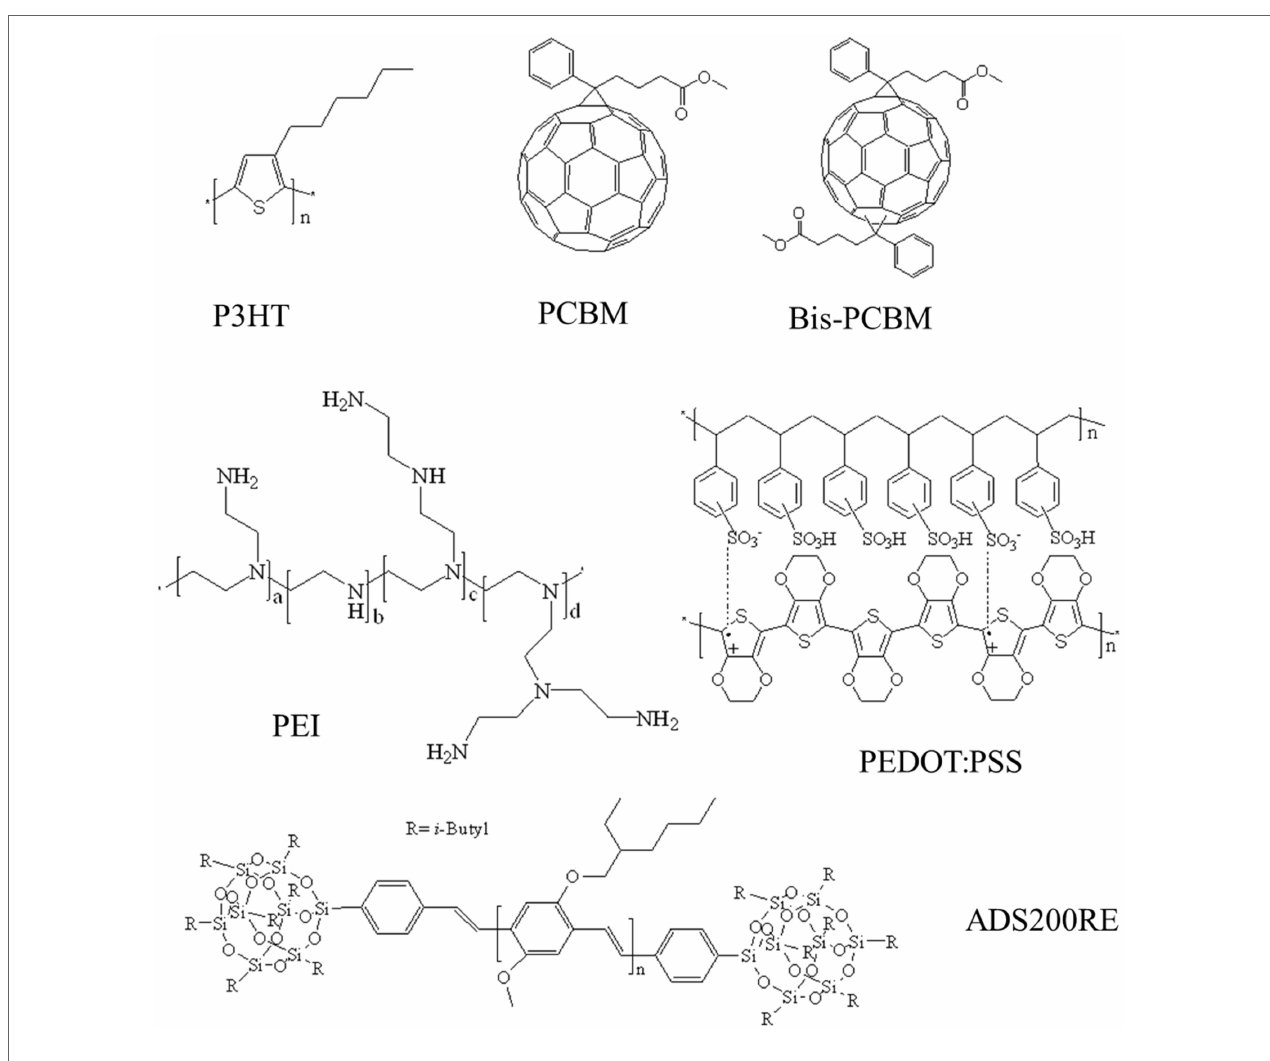
FigUre 2 | Photoactive and interlayer materials